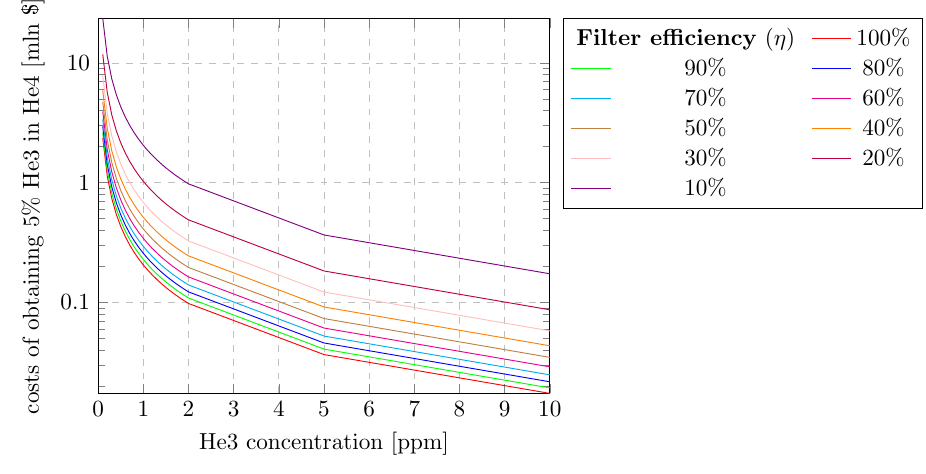
Figure 3. Cost of production He3.